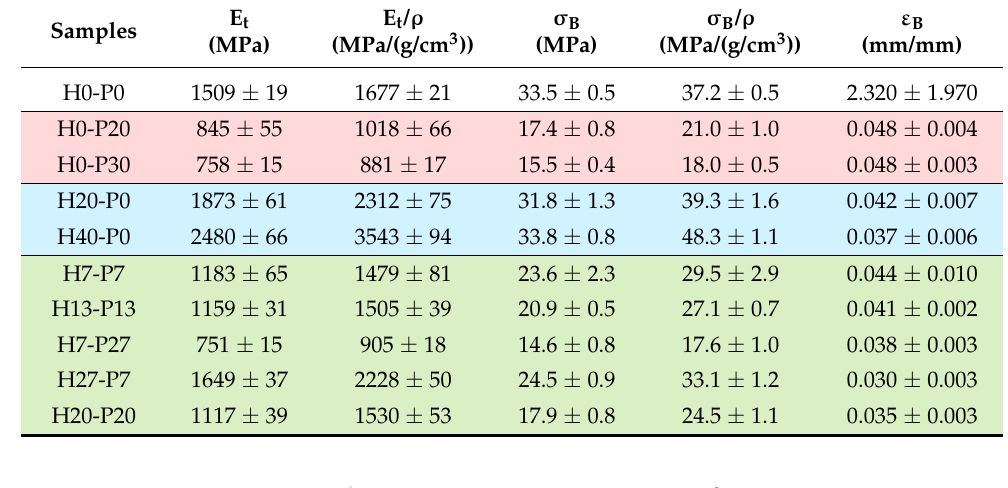
Table 5. Tensile mechanical properties of all the considered compositions.